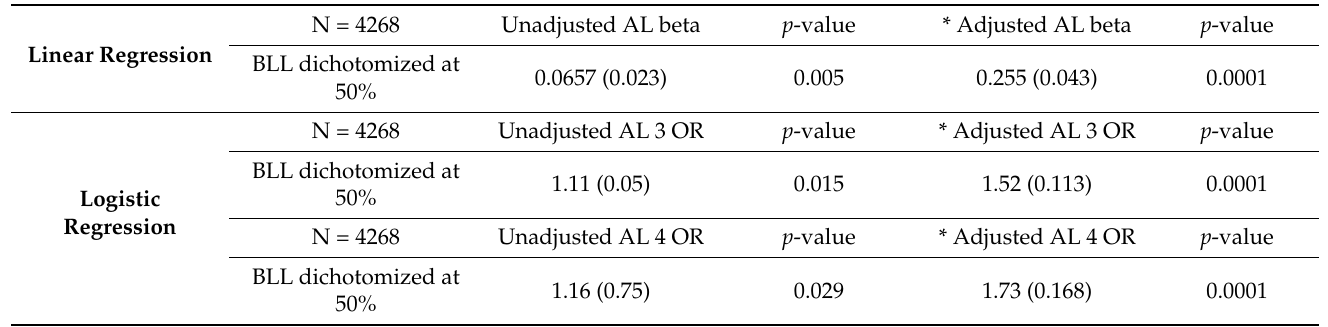
Table 2. Association between AL and BLL.